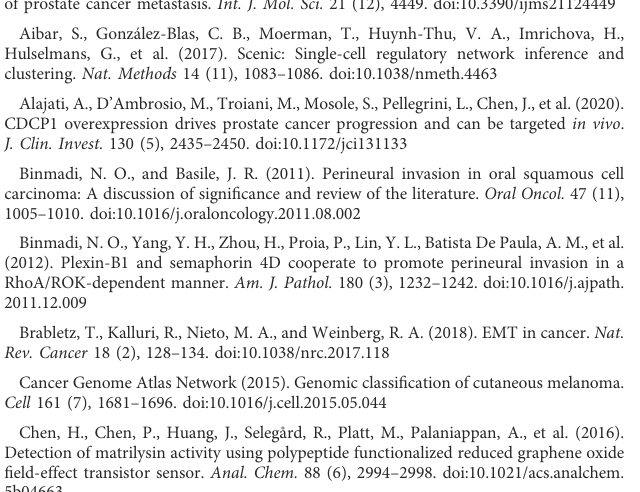
SUPPLEMENTARY FIGURE S1 (A – C) Pathological results revealed perineural invasion of the prostate cancer cells (hematoxylin and eosin staining) in three PCa patients. SUPPLEMENTARY FIGURE S2 Five subtypes generated from neural cells are demonstrated by